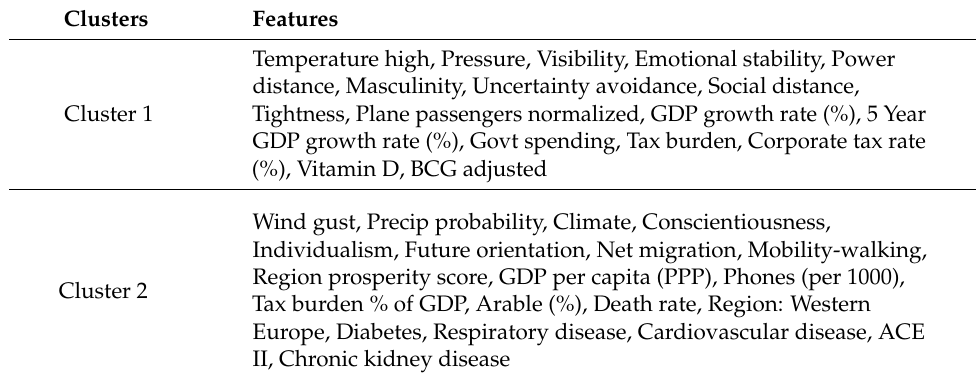
Table A1. Features, divided into four categories using K-means